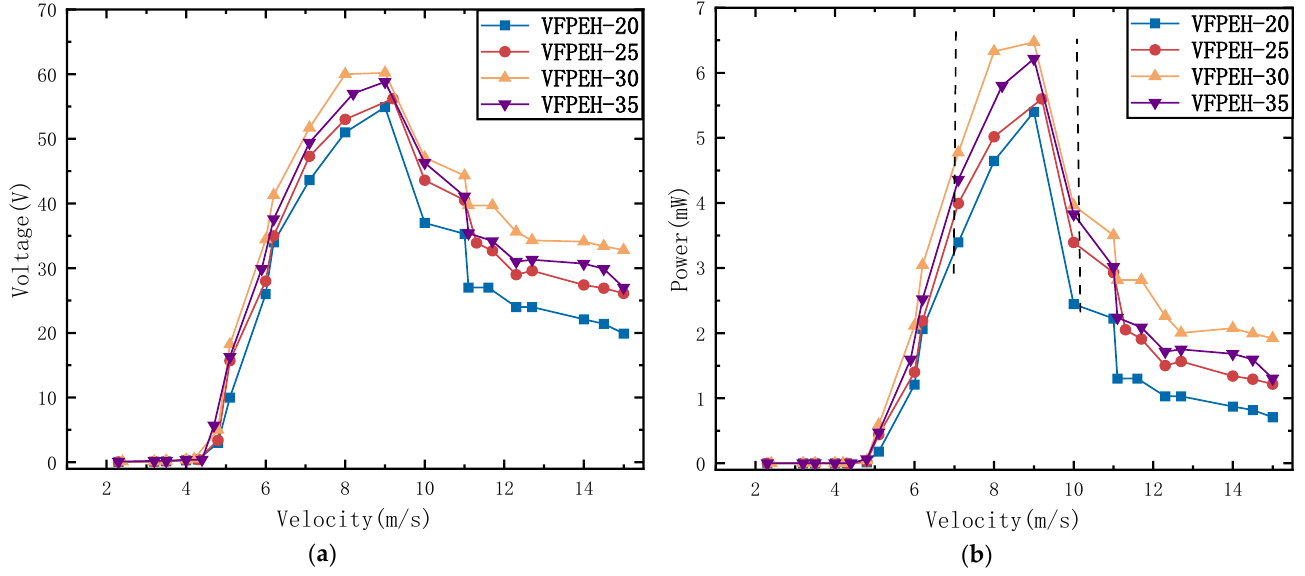
Figure 3. Output performance of the VFPEH at different cylindrical bluff diameters: ( a ) Output voltage; ( b ) Output power (matching resistance is 140 k Ω ).